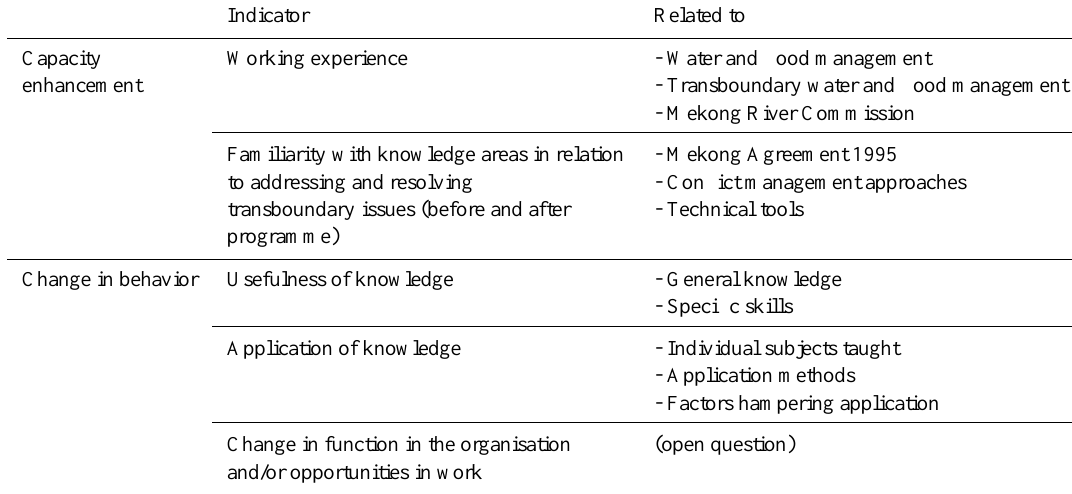
Table 2. Indicators assessed in the post-training survey.